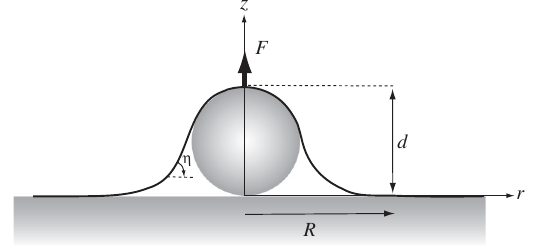
FIG. 8. Schematic of graphene supported on a single nano- particle. The detachment length is R